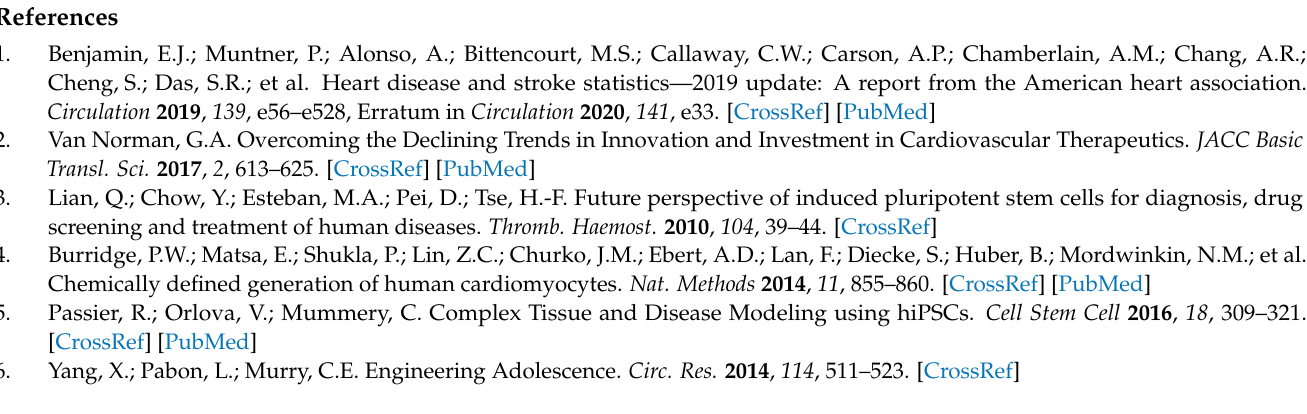
a milling machine; Figure S3: Bioengineered platform; Figure S4: Cardiomyocyte differentiation; Figure S5: Contraction & Relaxation velocity in different media; Figure S6: Contraction & Relaxation time in different media; Figure S7: Response to negative inotropic agents in hESC and hiPSC EHTs; Figure S8: Morphological analysis of EHTs; Figure S9: Relative gene expression of cardiac gen es for hESC CM BPEL+HS, DMEM+HS, MM+HS or MM(SF) at day 21 and Table S1: Primer sequences for